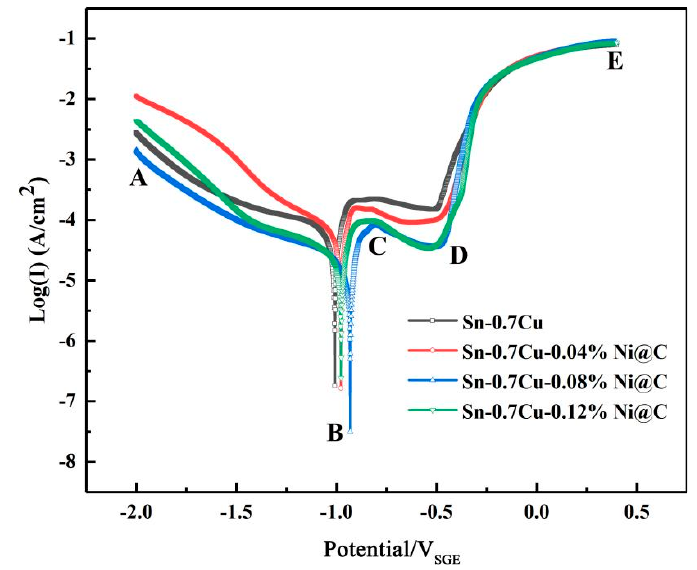
Figure 2. Polarization curve of Sn-0.7Cu-xNi@C ( x = 0, 0.04, 0.08, 0.12 wt.%) composite solder in 3.5 wt.% NaCl solution.